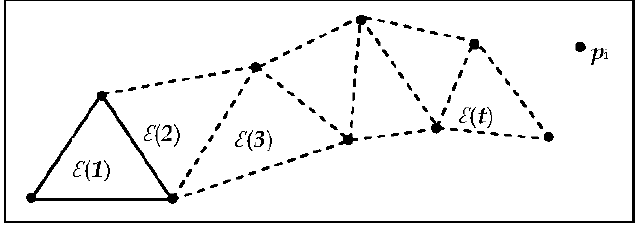
Figure 6. Grouping principles exemplified.